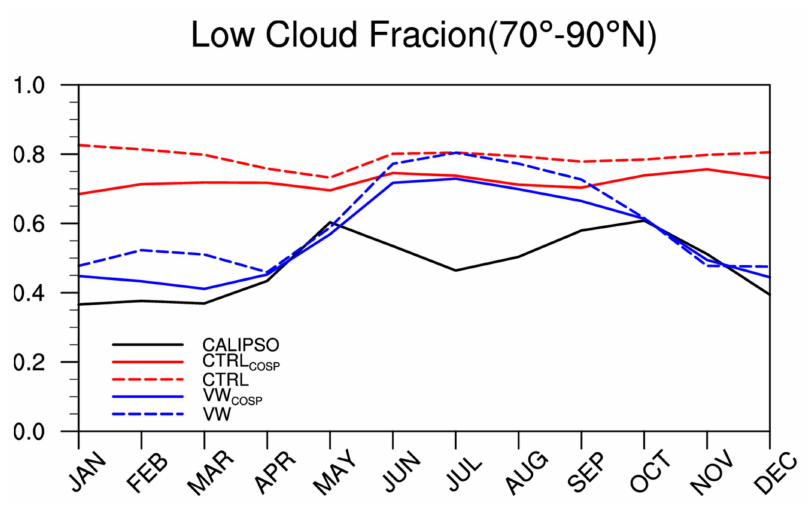
Figure 2. Annual cycles of the low cloud fraction averaged over the Arctic from CALIPSO-GOCCP observation (black), CTRL (red), VW (blue) The values were averaged from June 2007 to February 2010. Model variable is dotted lines, COSP variable is solid